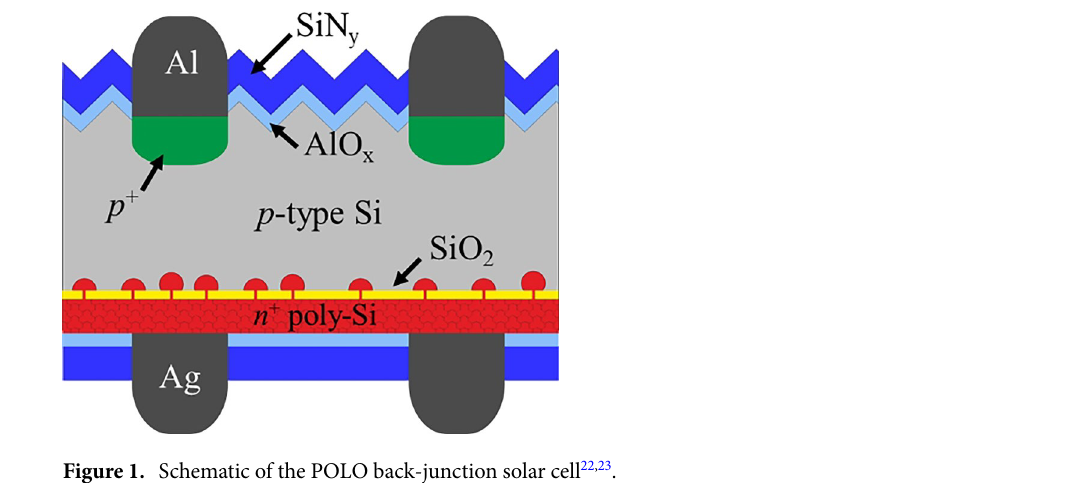
Figure 1. Schematic of the POLO back-junction solar cell 22,23